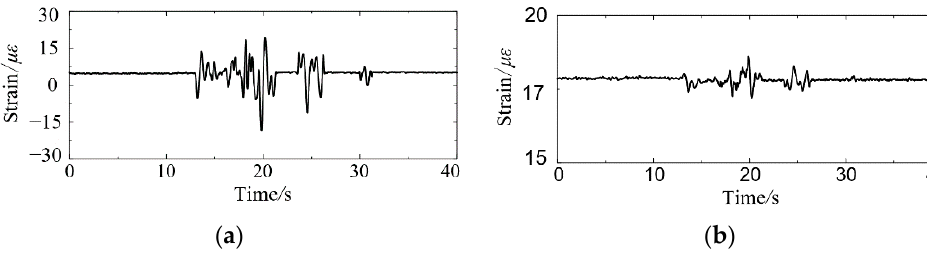
Figure 13. The strain responses at point S1 are caused by: ( a ) bending moment and ( b ) axial force.